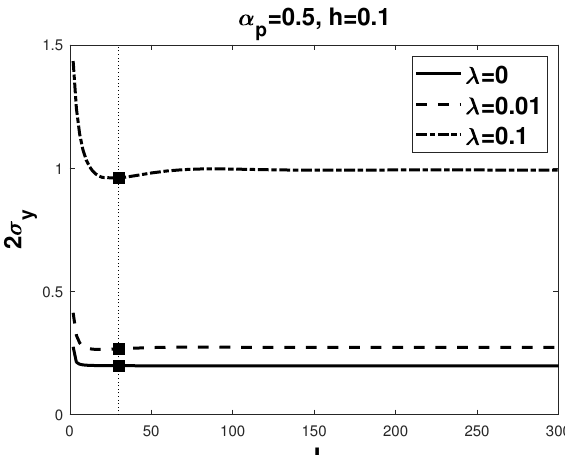
Figure 3. 2 σ y against J with limits on the control signal.